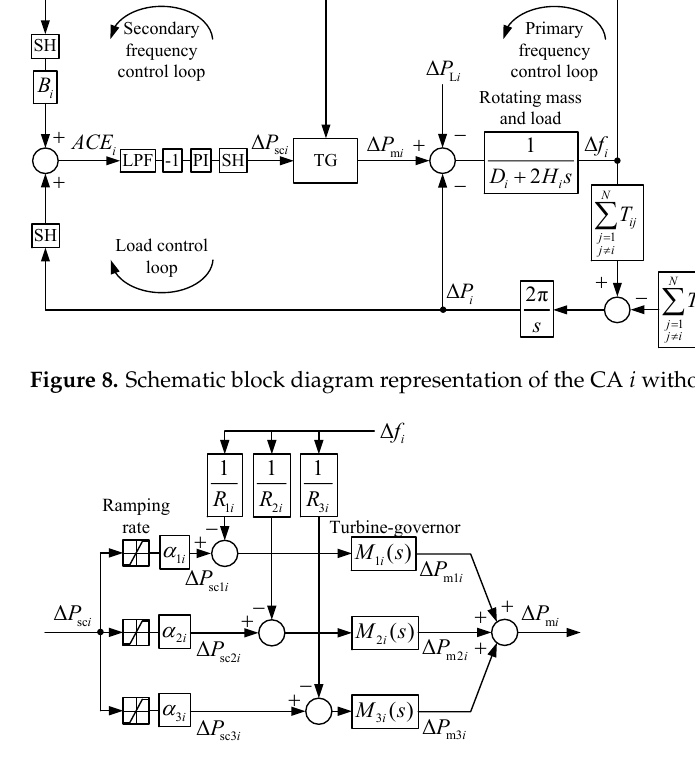
Figure 9. Schematic block diagram representation of the turbine-governor system with primary frequency control of the CA i